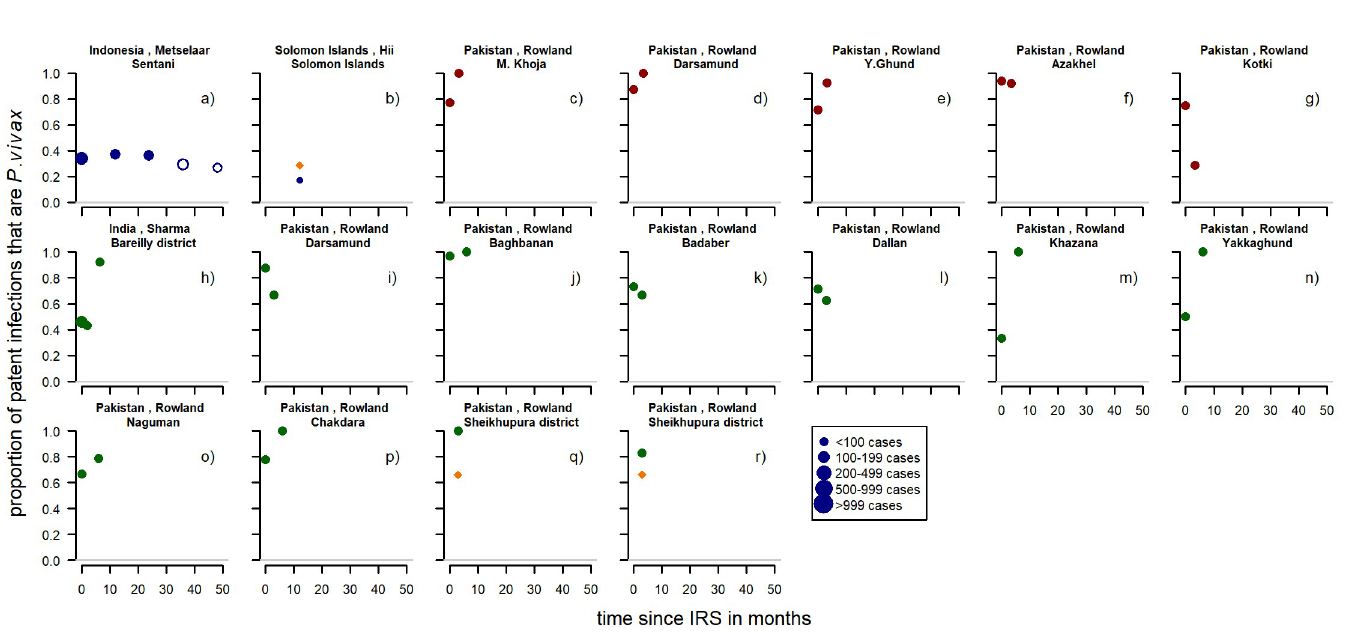
Fig 8. Proportion of patent infections that are P. vivax by time since IRS. Blue: first time spraying (there was no spraying for at least a year before), red: repeated spraying (spraying happened before but there was a change in insecticide used in panel f) and g)), green: unclear if spraying happened before (no mentioning of spraying before the study but also no clear mentioning of spraying being the first time). Open circles: more than 24 months after IRS, Orange diamond shaped dots are from the control group. Dot size depending on number of cases found. Pre-intervention points as described in Methods (definition of variables: time since implementation).